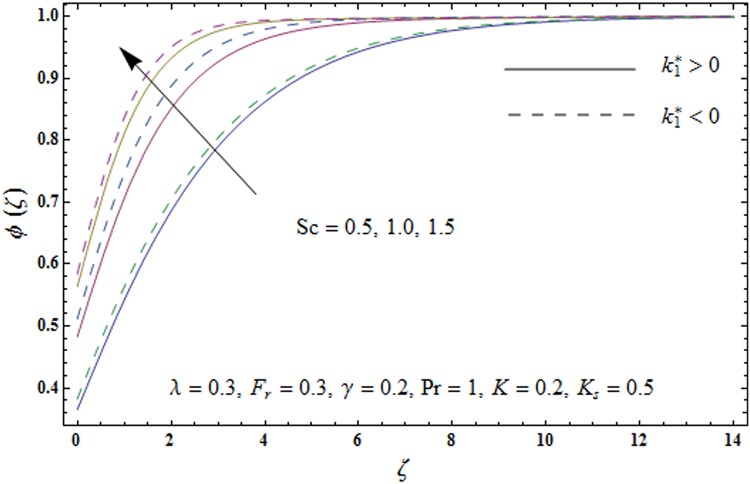
Plots of concentration field ϕ(ζ) for Schmidt number Sc.